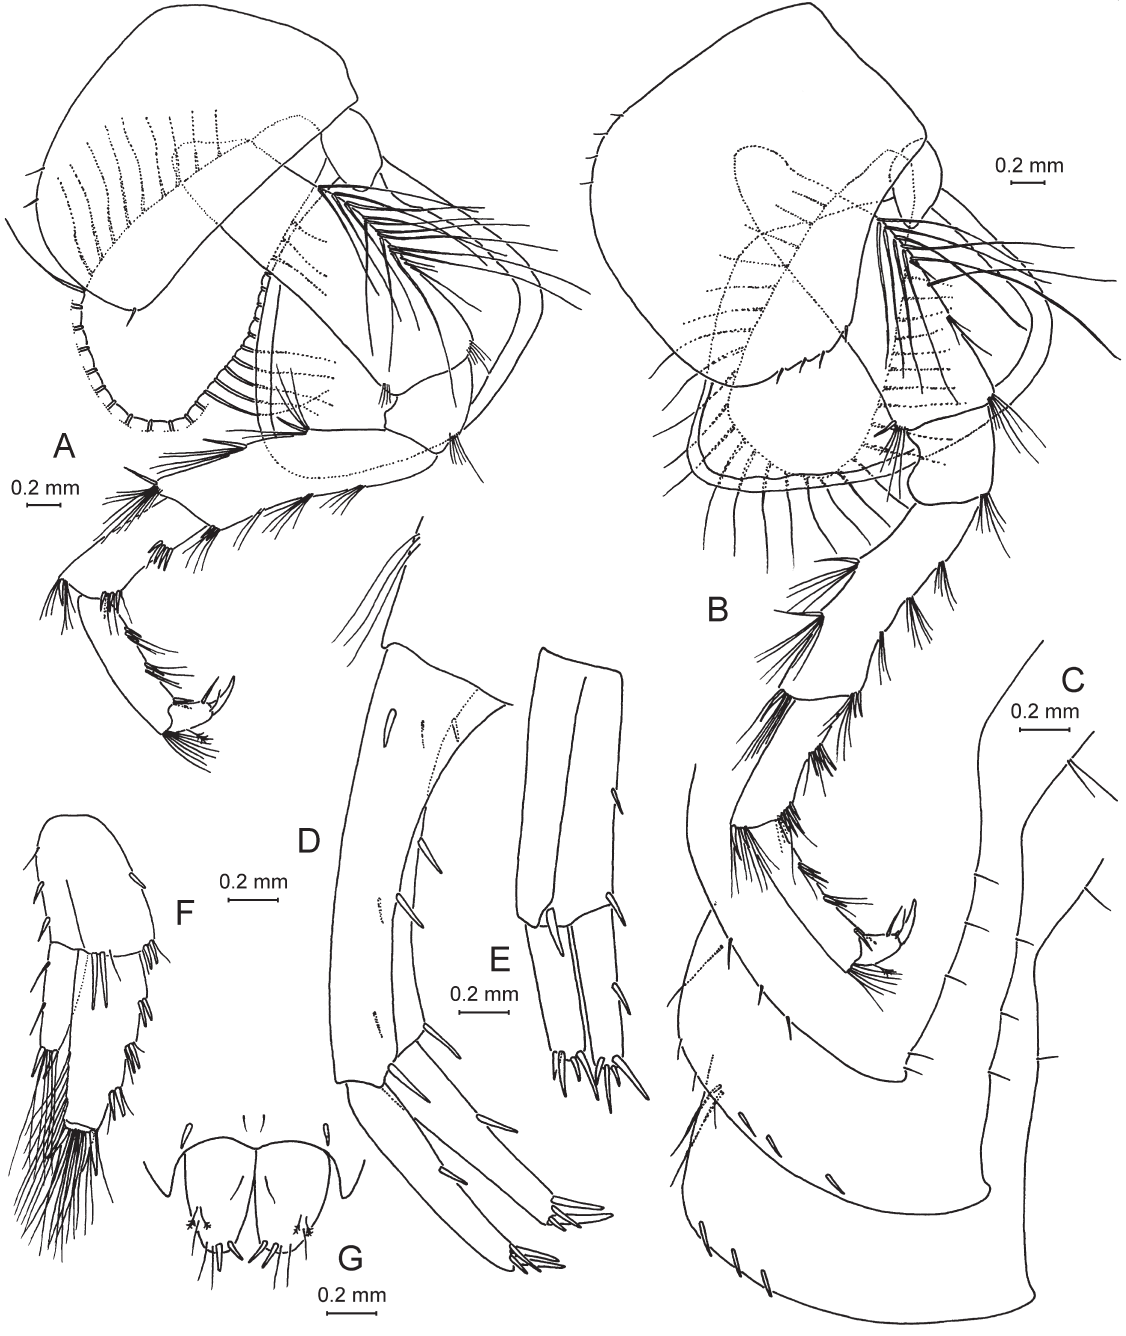
Fig. 14. Adaugammarus pilosus gen. et sp. nov. Holotype, ♀, 13.5 mm, X44046/Cr-1652-FEFU. A . Pereopod 3. B . Pereopod 4. C . Epimeral plates 1–3. D . Uropod I. E . Uropod 2. F . Uropod 3. G .